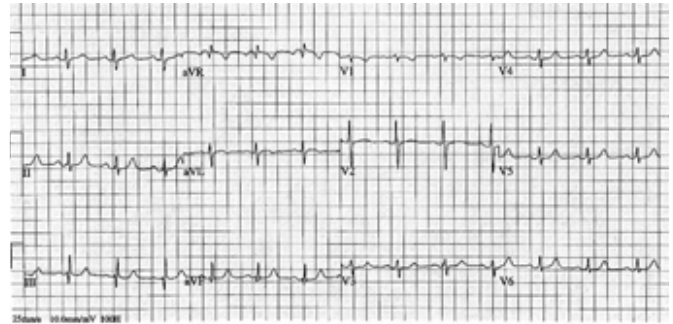
Figure 3. Post-nitroglycerine electrocardiogram with resolution of ST-elevation myocardial